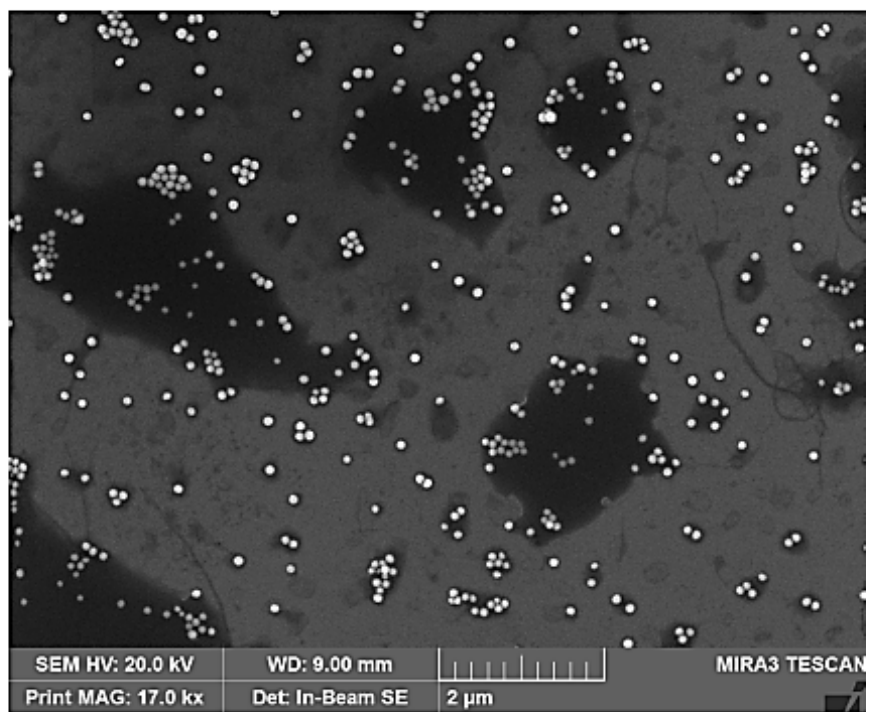
Figure 3. Scanning electron microscopy (SEM) of gold nanospheres .